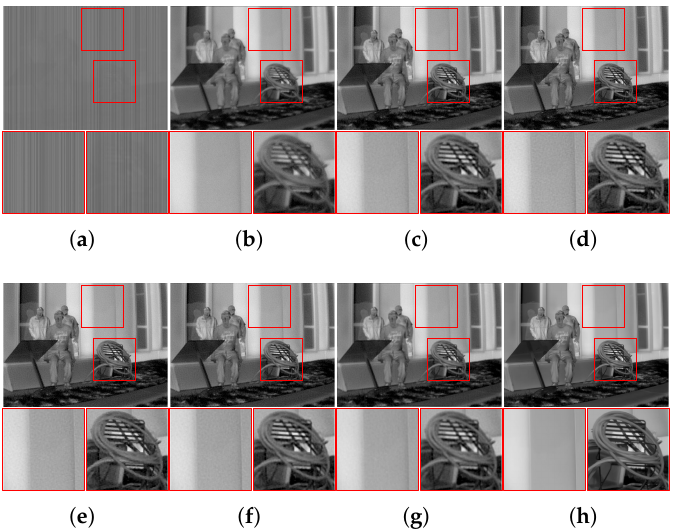
Figure 8. Thermal image deconvolution results of synthesized images restored by non-blind image deconvolution algorithms. ( a ) Degraded image; ( b ) initially denoised image [14]; ( c ) Levin et al. [6]; ( d ) Liming et al. [8]; ( e ) Jon et al. [11]; ( f ) Lee et al. [10]; ( g ) proposed; ( h ) original image. Table 2. Quantitative measurements of restored infrared image qualities of non-blind deconvolution algorithms using four quality assessments: PSNR, SSIM, Ro, and